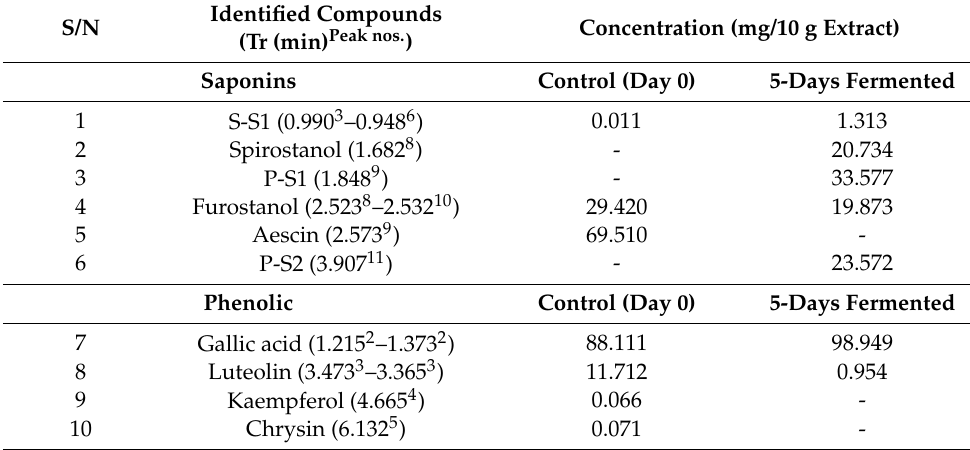
Table 4. Phytochemical compounds in E. faecium fermented S. monostachyus leaves. S/N (Tr (min) Peak nos. )